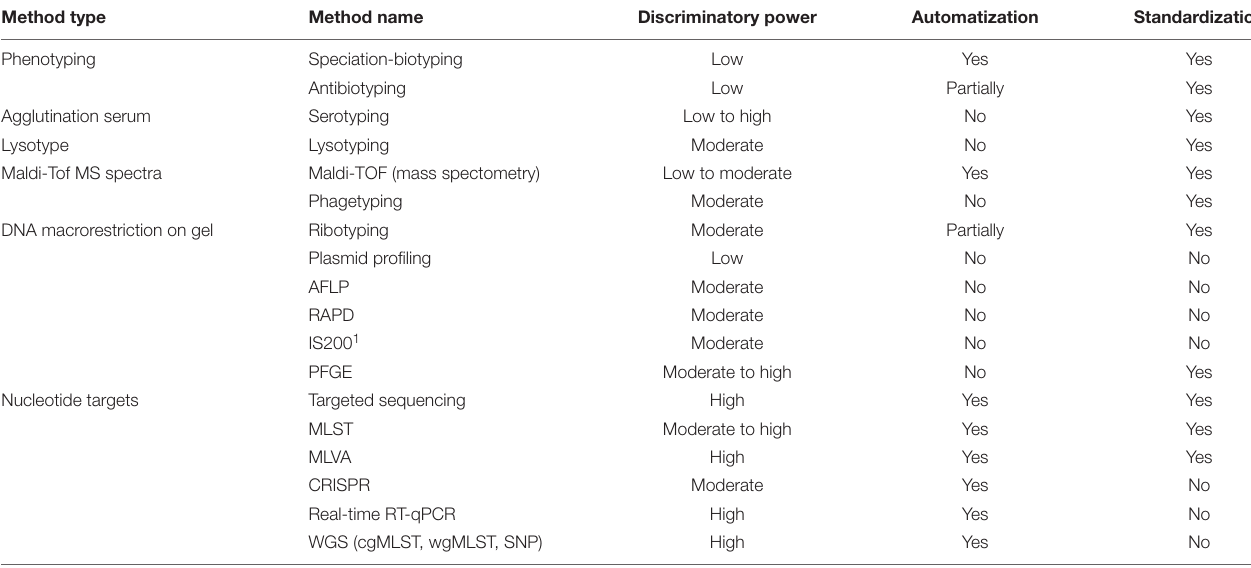
TABLE 1 | Typing methods and their discriminatory power, level of automation and